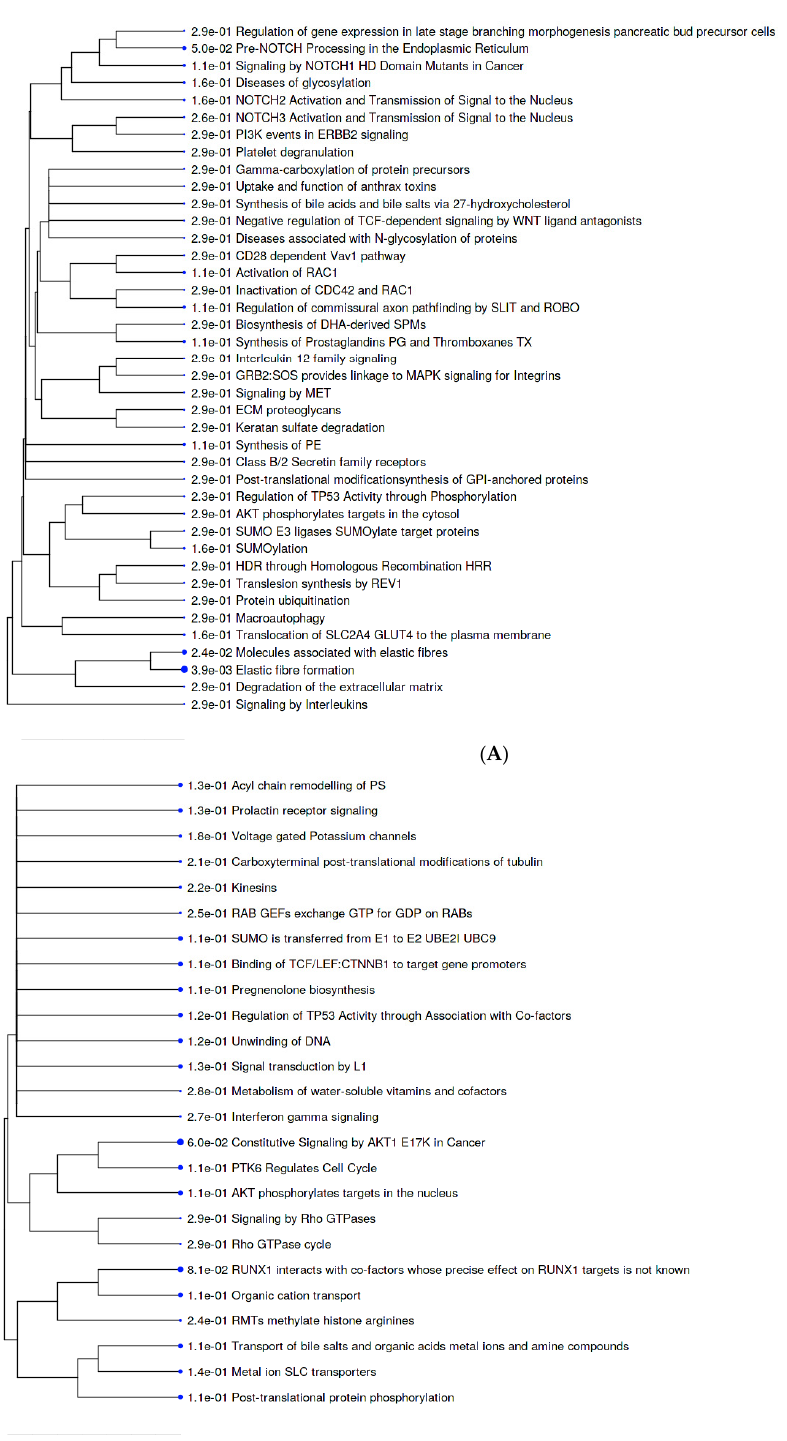
Figure 4. Hierarchical tree representation of the reactome metabolic pathway categories of genes encoding ( A ) AFP 14–20 ‐ like motif ‐ containing proteins and ( B ) GIP ‐ 9 ‐ like motif ‐ containing proteins. The tree summarizes the correlation among significant pathways in the gene enrichment list. Pathways with many shared genes are clustered together. Larger dots indicate more significant p ‐ values.